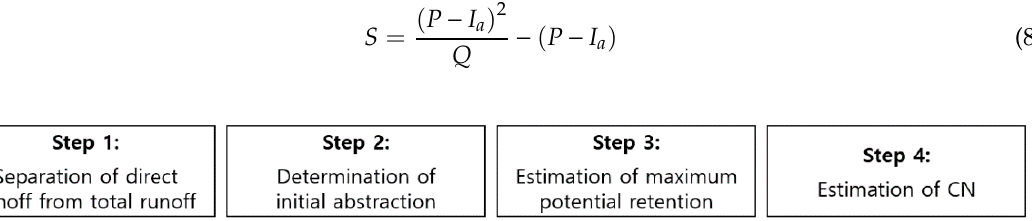
Figure 1. The procedure adopted in this study for estimating the parameters of the Soil Conservations Service–Curve Number (SCS–CN) method.